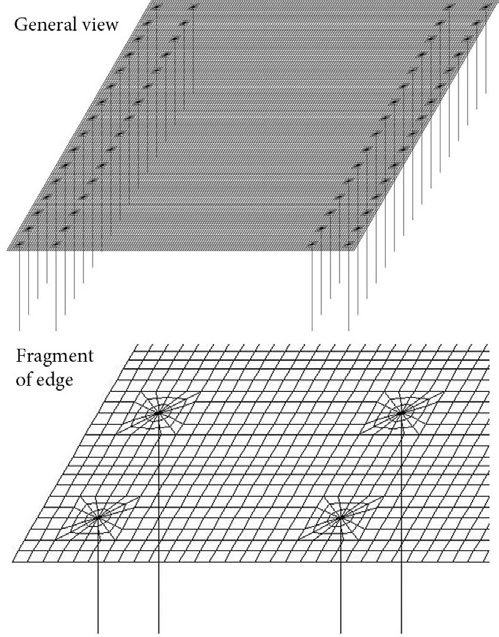
fig. 5. The spatial numerical model of the piled raft variant II,